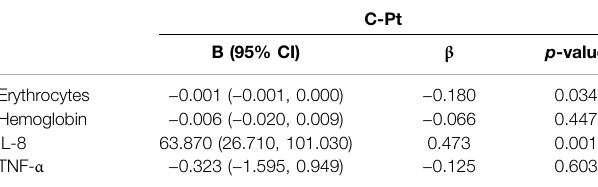
TABLE 4 | Correlations between cytokines, hemocytes and C-Pt.